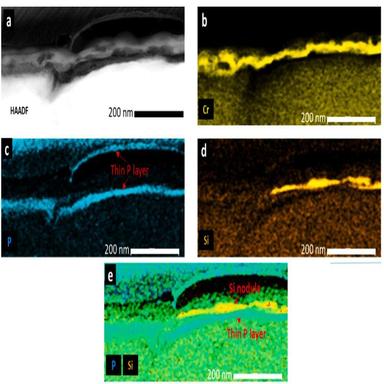
The enlarged HAADF-STEM image of the oxide film (red rectangle in a) after phosphating (a), the corresponding EDX spectra of Cr, P, and Si (b-d), and the overlay map of P and Si (e).